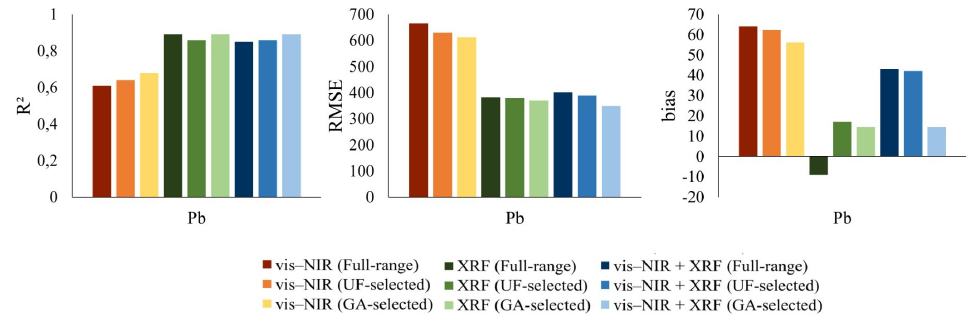
Figure 6. Pb (mg/kg) prediction model performance using different spectral data sets.